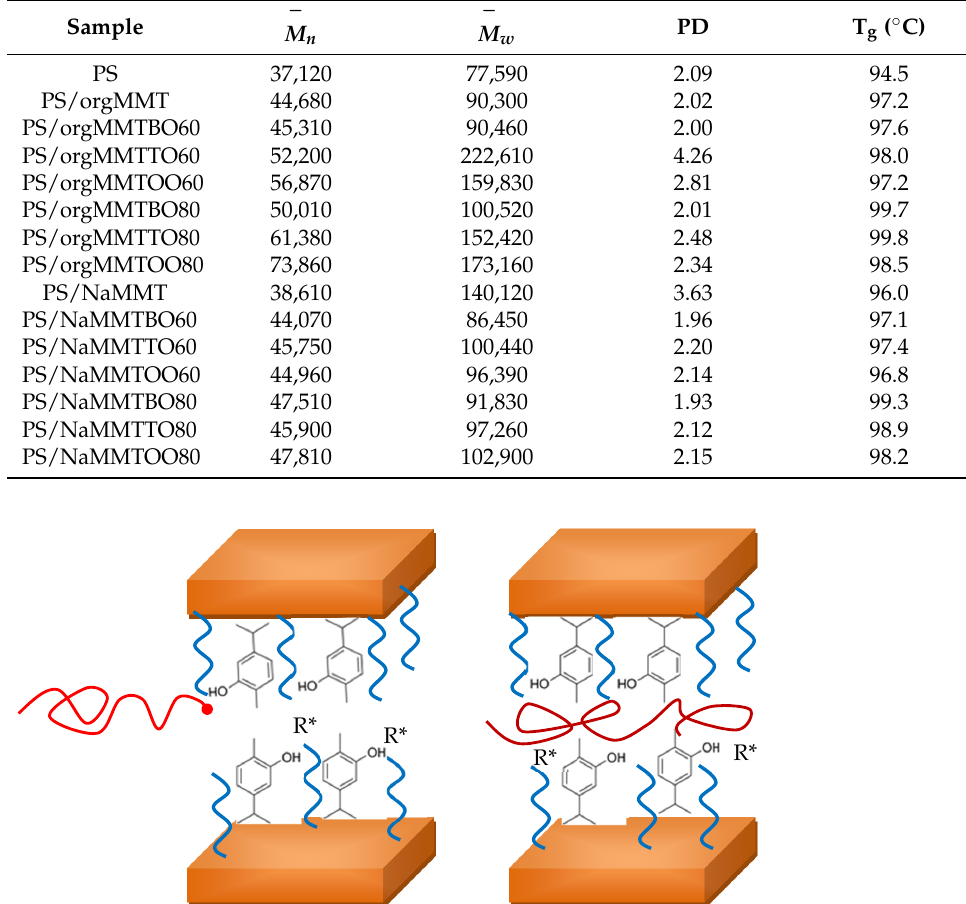
Table 2. Number- and weight-average molecular weights ( M n , M w ), as well as polydispersity of the MWD (PD) together with the glass transition temperature (T g ) of neat PS and its nanocomposites with the sodium or organo-modified montmorillonite (MMT) with or without the essential oils.